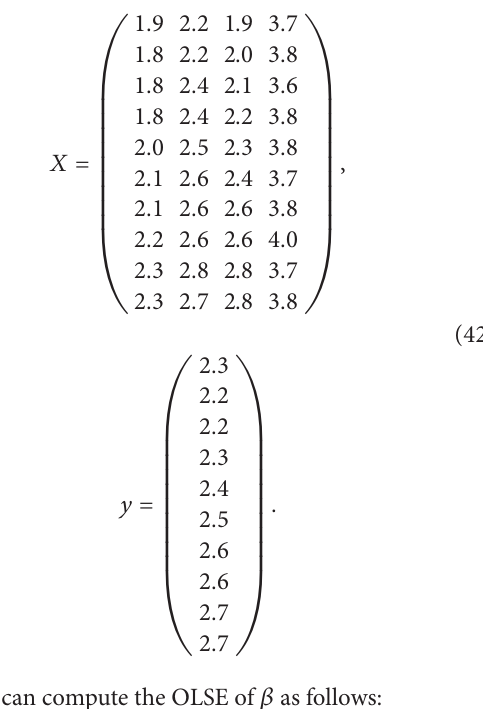
̂𝛽(𝑘, 𝑑)) < 𝑀( ̂𝛽 (𝑘, 𝑑)) 𝑟